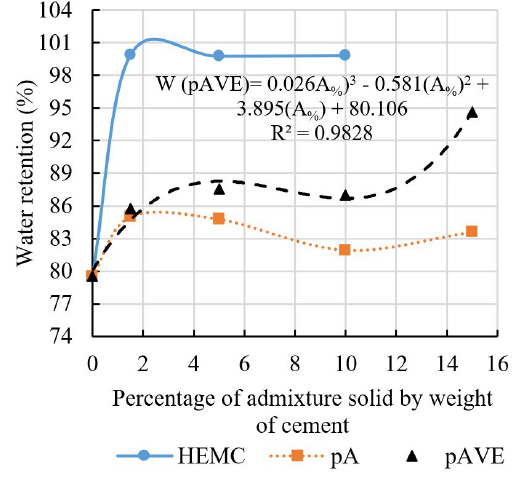
Figure 4. Water retention